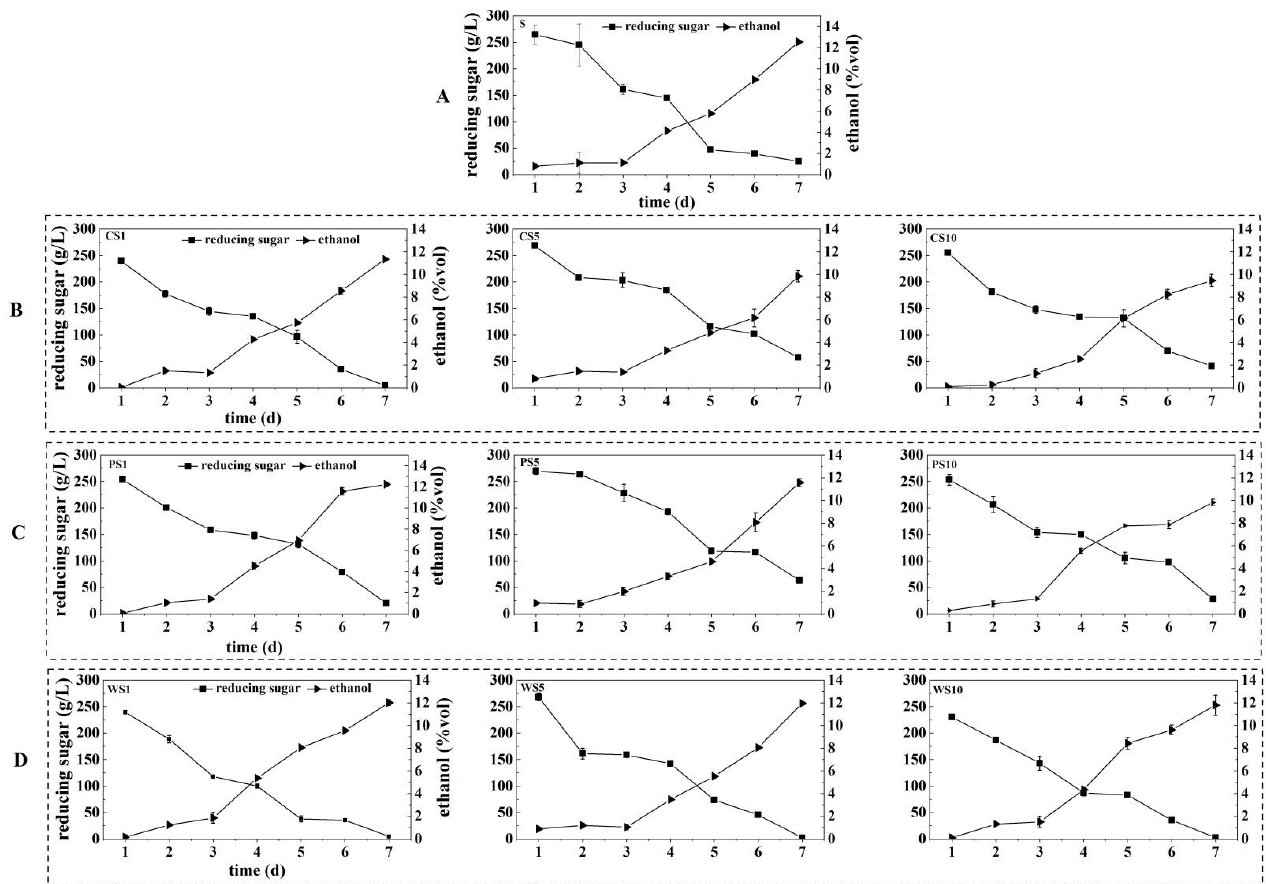
Figure 3. Changes in ethanol and reducing sugar contents of different ester-producing yeasts, with S. cerevisiae NCUF309.2 at different ratios during the simulated fermentation of blueberry wine. ( A ) pure fermentation of S. cerevisiae NCUF309.2; ( B ) co-fermentation of C. glabrata NCUF308.1 and S. cerevisiae NCUF309.2; ( C ) co-fermentation of P. anomala NCUF306.1 and S. cerevisiae NCUF309.2; ( D ) co-fermentation of W. anomalus NCUF307.1 and S. cerevisiae NCUF309.2.